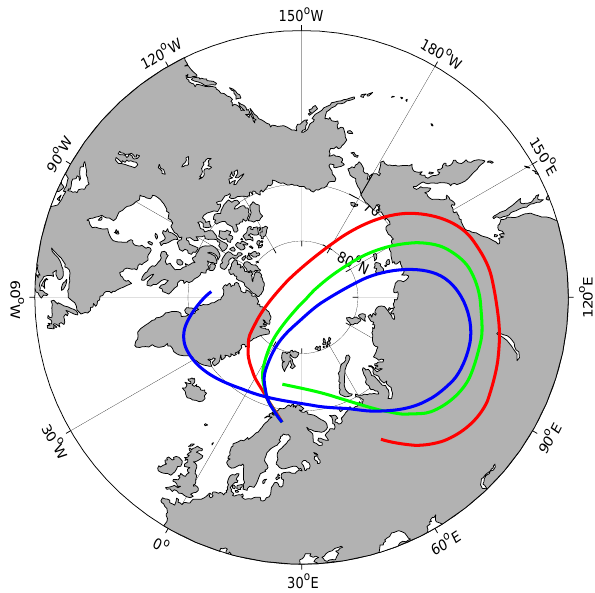
Fig. 5. Trajectories calculated 6-days backward starting at the Es- range (67.8 ◦ N, 21.1 ◦ E) for the measurements made on 23 January on 19:00UT at three different altitude levels, 19km (red), 22km (green) and 25km